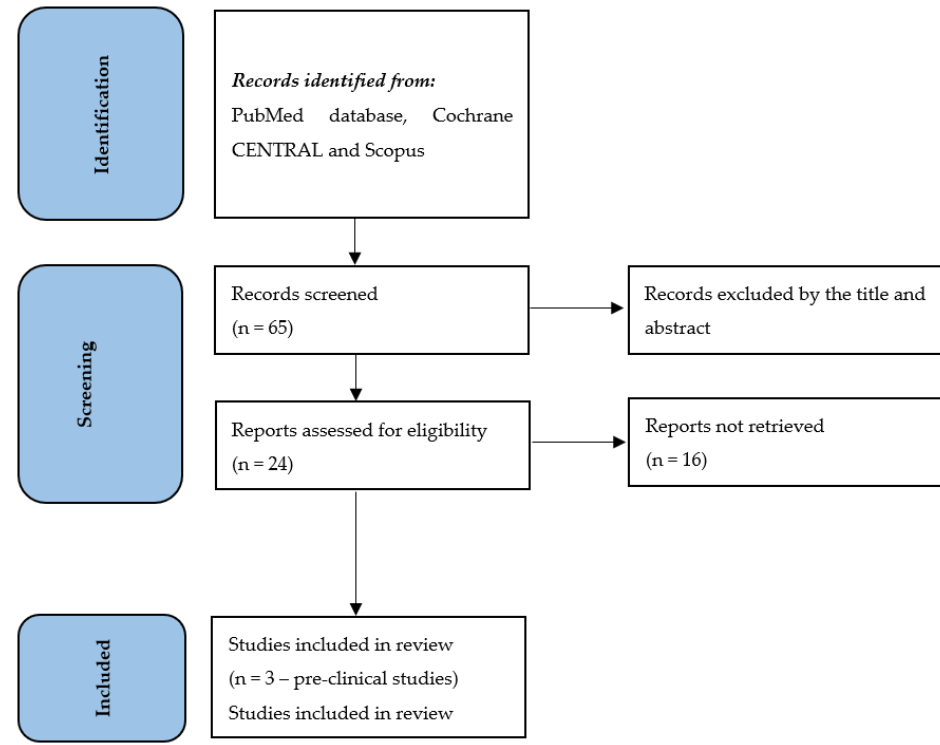
Figure 1. The flowchart of the literature search in line with the PRISMA